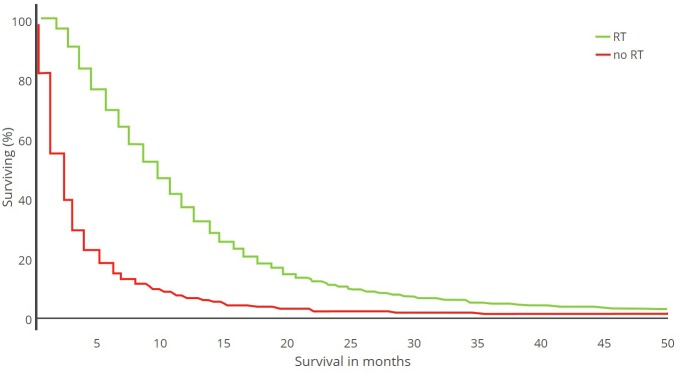
Kaplan–Meier plot. Survival analysis of 21,783 GBM patients treated with radiotherapy (RT) versus no RT (1973–2007) [adapted from Zinn et al. (2013)].